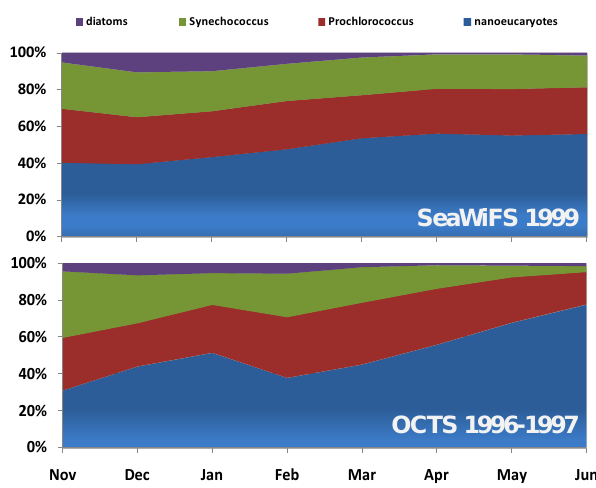
The monthly areal coverage (in percentage) by each PFT (i.e., Prochlorococcus, Synechococcus, nanoeucaryotes and di- atoms) obtained from OCTS (1996–1997, bottom panel) and SeaW- iFS (1999, top panel). This was calculated from the data presented in Fig.